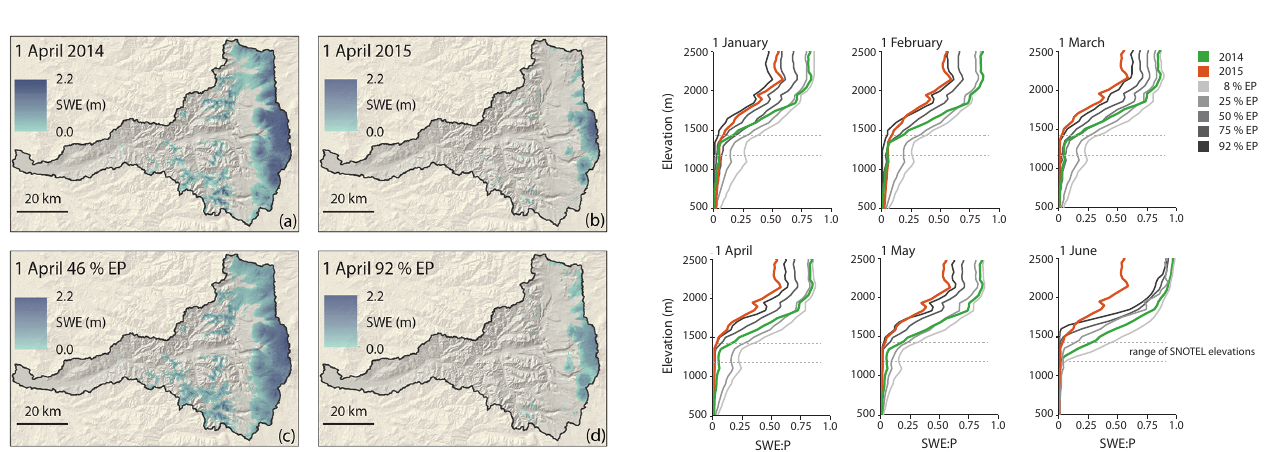
Figure 6. The ratio of SWE : P binned by 50m elevation bands. The relationship between elevation and SWE : P is evident across all exceedance probabilities. Under + 2 ◦ C simulations and in 2014 and 2015, roughly 1500m is the elevation at which SWE : P be- gins to increase substantially along the horizontal axis. Note that, on the vertical axes, snow water storage below 500 and above 2500m is not included for visual clarity. These elevations contribute mini- mally to basin-wide snow water storage. The calculations are 5-day averages centered on the first day of each